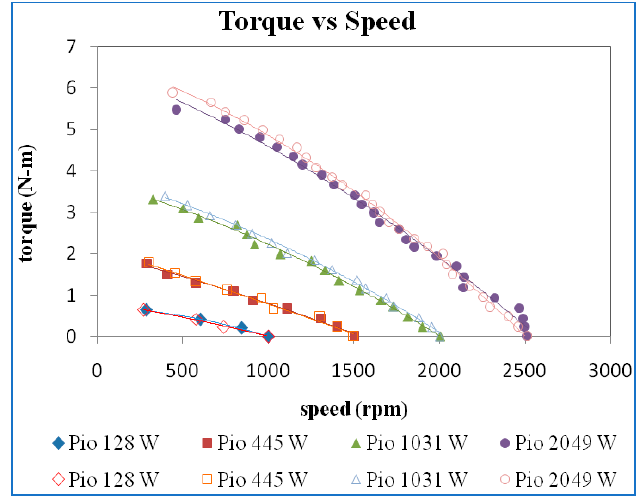
Figure 6. Torque vs. speed at a guide vane opening of 10 mm.